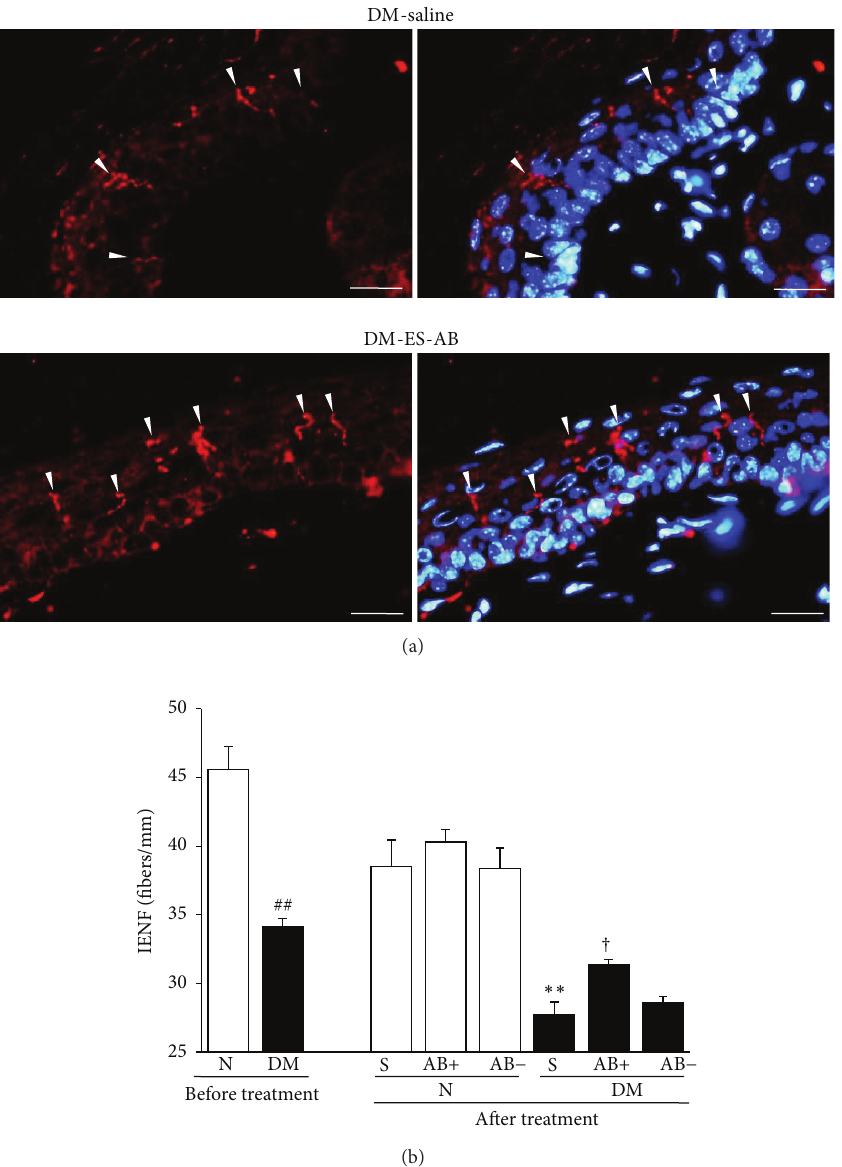
Figure 10: Intraepidermal nerve fibers (IENFs) were preserved by angioblast-like cells induced from ES cells (ES-ABs). (a) IENFs in plantar skins were visualized with PGP9.5 antibody (red). After 15 weeks of diabetes, IENF densities were decreased in diabetic mice (upper) and the impairmentwasrestoredbyES-ABstransplantation(lower).DM-saline:plantarskinofsaline-injectedlimbsindiabeticmiceandDM-ES-AB: plantar skin of limbs transplanted ES-ABs in diabetic mice. White arrowheads: IENFs. (b) Quantification of IENF densities demonstrated that IENFs were significantly decreased in diabetic mice compared with those in normal mice at 12 weeks of diabetes and this decrease was significantly ameliorated by transplantation of ES-ABs. However, administration of ES-ABs did not change IENF densities in normal mice. N: normal mice limbs, DM: diabetic mice limbs, S: saline-injected limbs, AB+: limbs transplanted ES-ABs, and AB − : contralateral limbs transplanted ES-Abs. Results are means ± SD. ## 𝑃 < 0.005 versus pretreatment N, ∗∗ 𝑃 < 0.005 versus posttreatment S-treated N, and † 𝑃 < 0.05 versus posttreatment S-treated DM. 𝑛 = 3 -4 in each